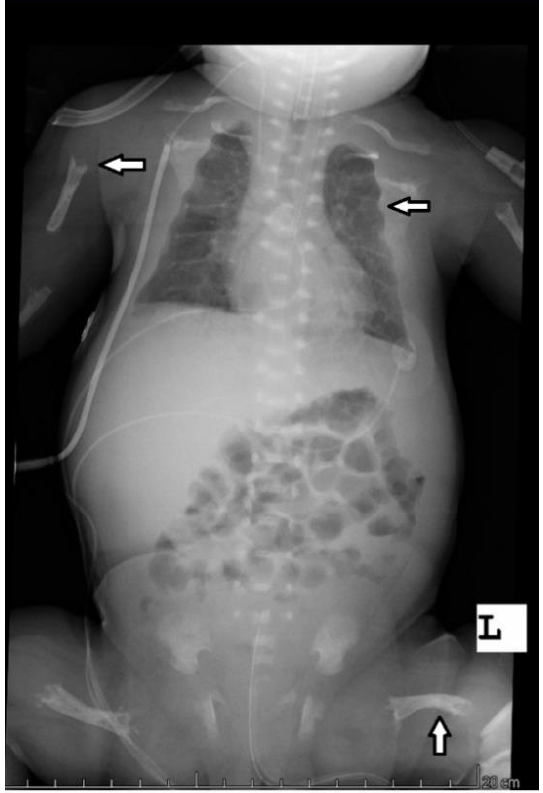
Figure 1. Babygram of a patient with the perinatal disease type — disturbances in bone mineralization, bone structure, uneven edges of the epiphyses, and bone deformities after fractures.